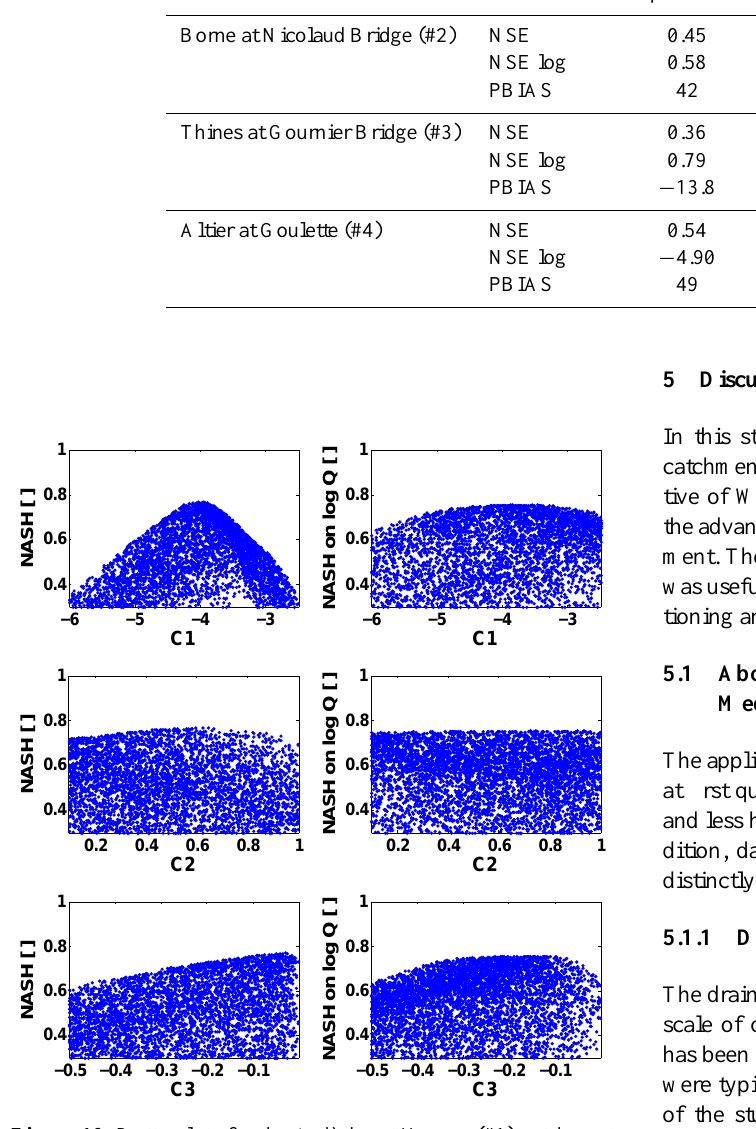
Figure 10. Dotty plots for the Ardèche at Meyras (#1) catchment (left: plots with NSE efficiencies; right: plots with NSE efficiencies calculated on log Q